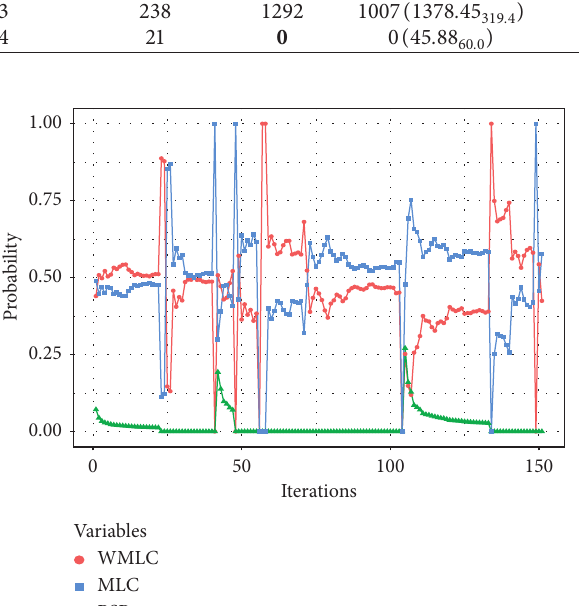
Figure 3: Diversification heuristics.